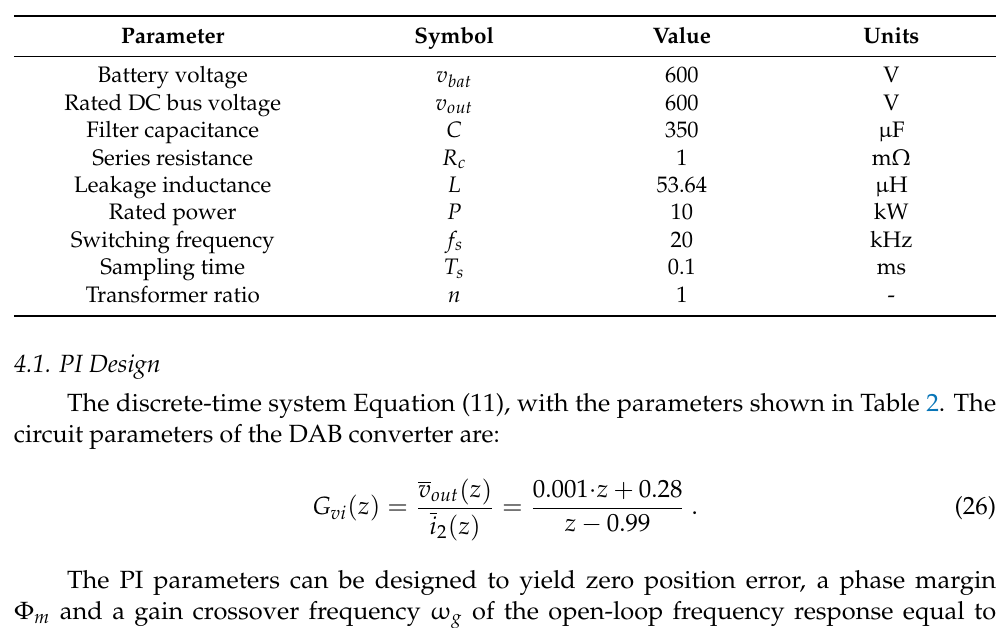
Table 2. Circuit parameters of the dual-active-bridge